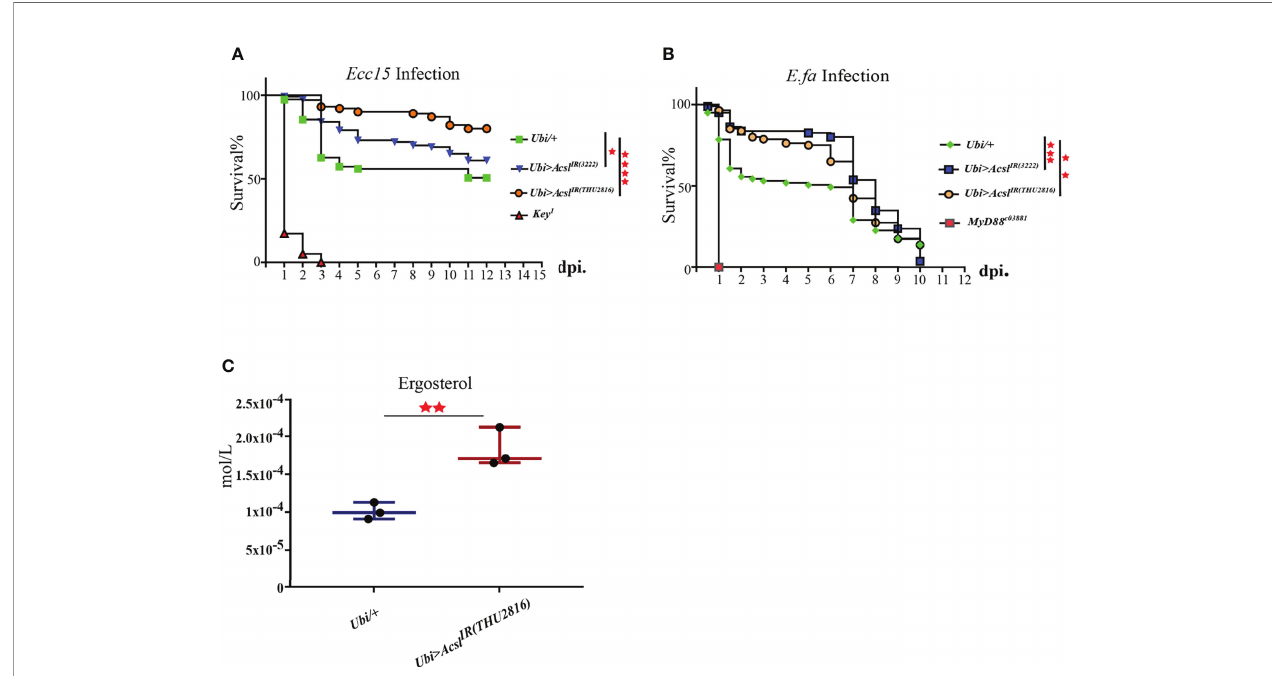
FIGURE 4 | Flies with Acsl depletion are more resistant to bacterial infection than the wild type. (A) . Survival curves of Acsl RNAi and key 1 fl ies infected with Ecc15 . *, p<0.05; ****, p<0.001. (Gehan-Breslow-Wilcoxon test). (B) . Survival curves of Acsl RNAi and Myd88 c03881 fl ies infected with E.fa . **, p<0.01; ***, p<0.005. (Gehan- Breslow-Wilcoxon test). (C) . Box plot of ergosterol in control and Acsl RNAi fl ies. **, p<0.01 (wilcox